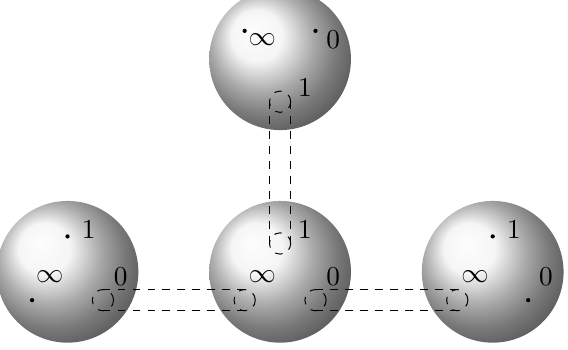
Figure 8 . The plumbing construction for the 6-point non-linear